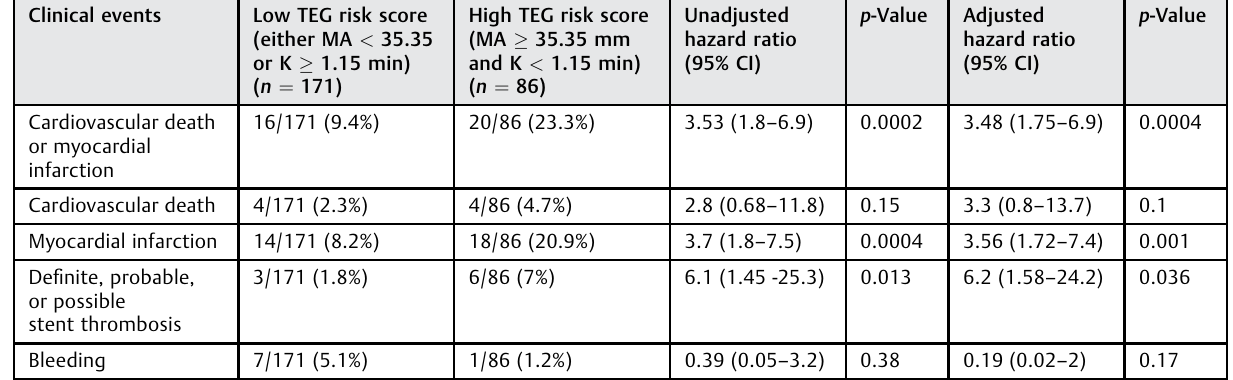
Table 4 Unadjusted and adjusted hazard ratio for clinical outcomes associated with presence of combination of high MA and low K in Cox regression analysis Clinical events